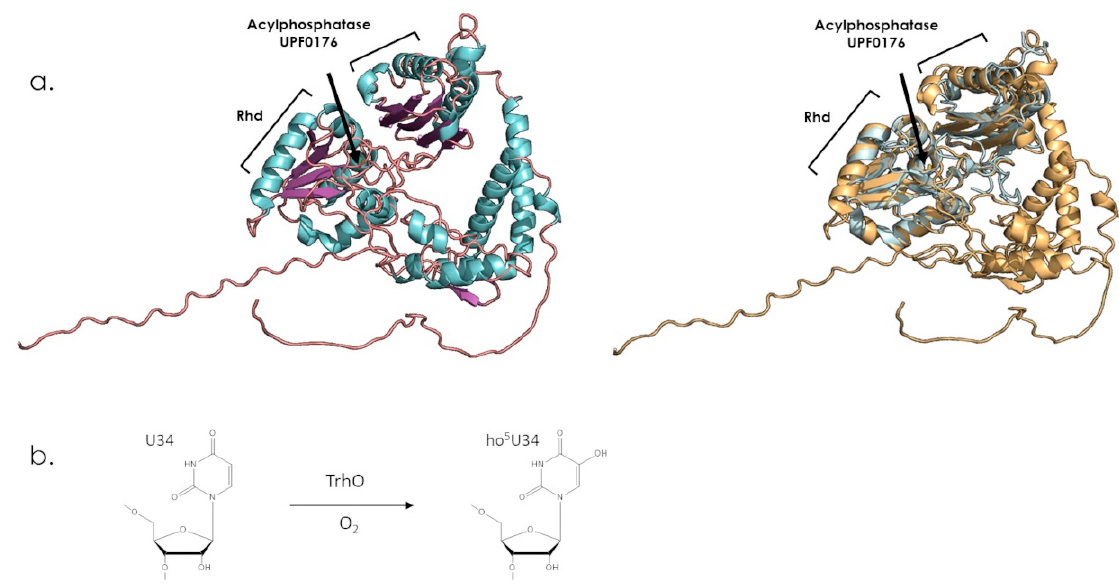
Figure 11. The TSTD2 structural model and reaction catalyzed by E. coli counterpart. ( a ) Left: the TSTD2 Alphafold predicted structure (AF-Q5T7W7). Acylphosphatase (UPF0176/IPR001792) and Rhd domains are indicated. Right: structure superimposition, using Pymol (version 2.4.1) (RMSD = 1.073 Å on remaining 1149 atoms), of the TSTD2 AlphaFold model (Gold) with the Legionella pneumophila protein structure (PDB 4F67, Pale green, Q5ZRP2, UniProt). Putative catalytic loop cysteine residue is represented as stick and is indicated by a black arrow. ( b ) The oxygen dependent tRNA U34 hydroxylation ( ho5 U34) catalysed by TrhO, the TSTD2 orthologous protein from E. coli